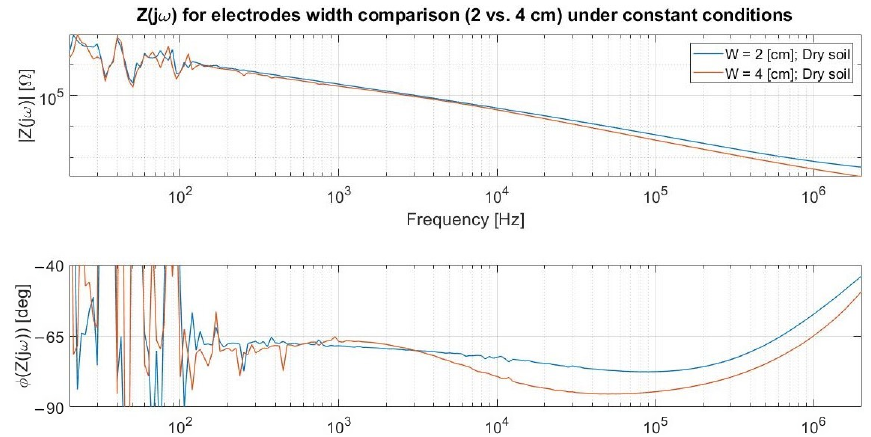
Figure 7. The LCR outcomes confirm that wider electrodes increase C Kp but do not grant a noteworthy variation on its zero preceding the resistive plateau due to a concomitant R Soil reduction.